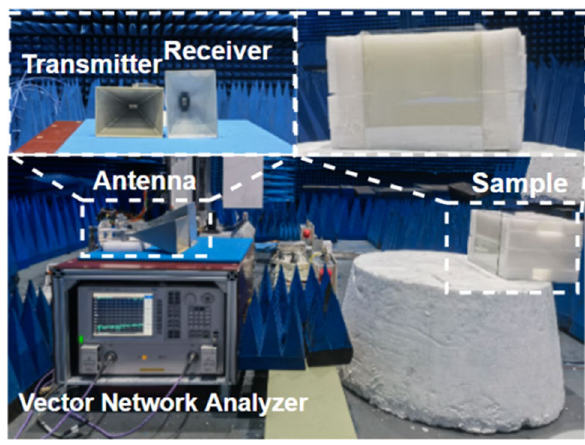
Figure 8. Measurement of the PCR spectra in the microwave